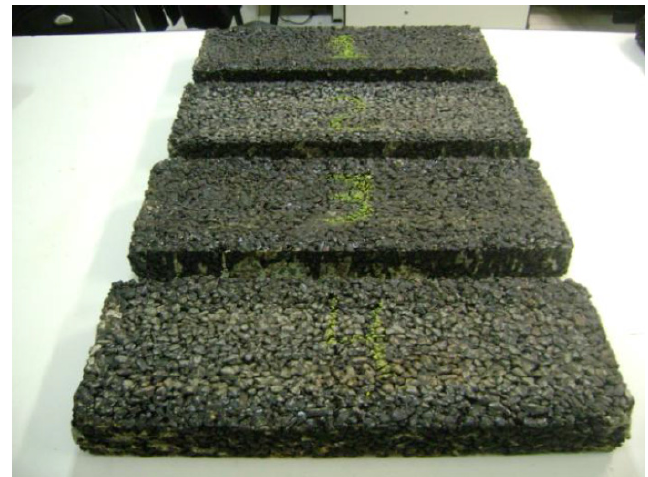
Figure 1. Slabs of draining asphalt concrete used in the study. Table 1. Slabs of draining asphalt concrete and their modifiers.